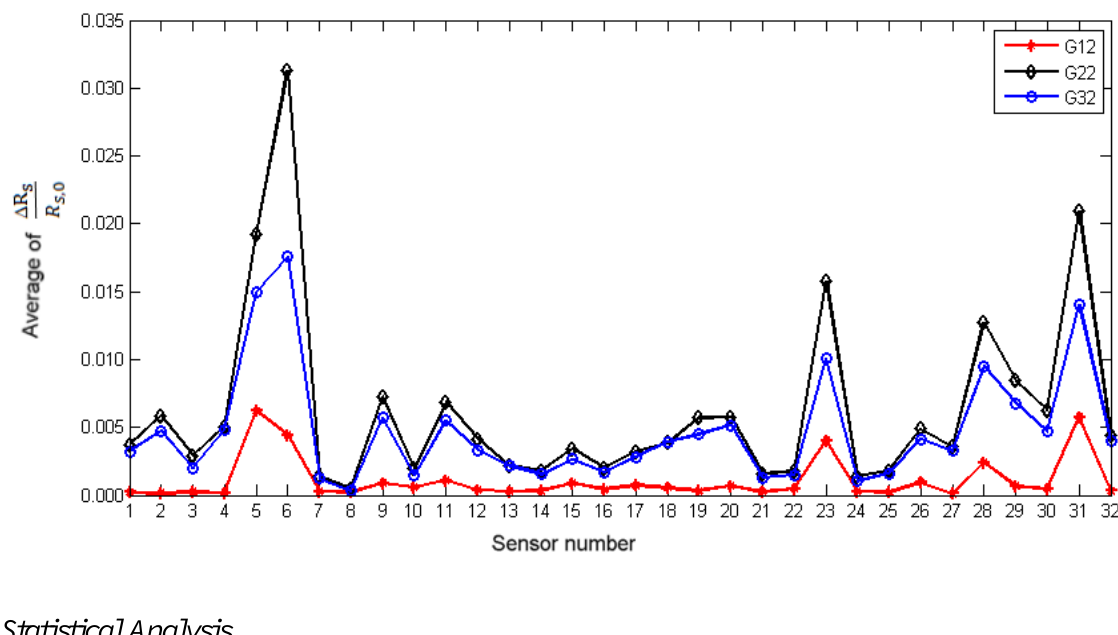
Figure 4. Smellprints of three different agarwood